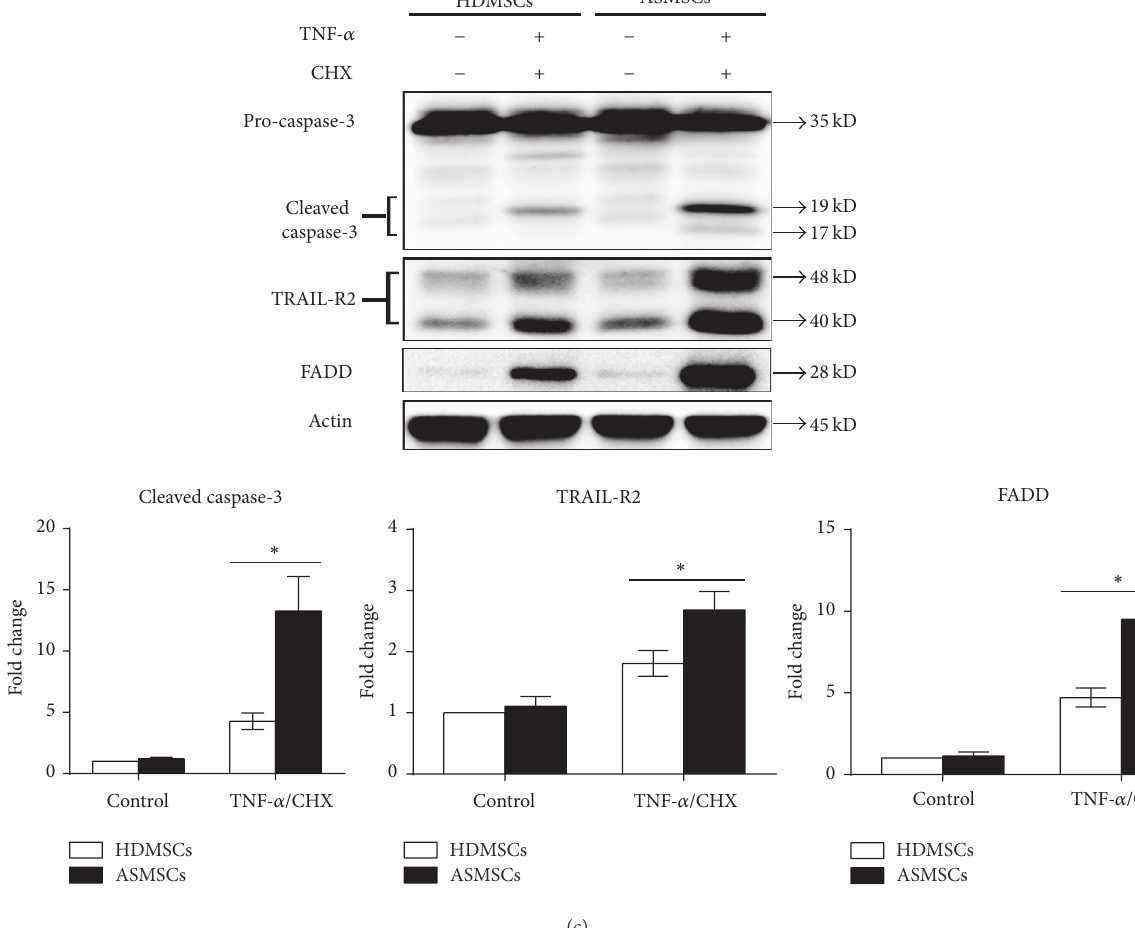
Figure 3: ASMSCs had increased protein expression of cleaved caspase-3, TRAIL-R2, and FADD and increased gene expression of TRAIL- R2 and FADD during apoptosis. (a) The Proteome Profiler (cid:2) Human Apoptosis Array Kit was used to determine the expression levels of 35 apoptosis-related proteins in HDMSCs ( 𝑛 = 6 ) and ASMSCs ( 𝑛 = 6 ) after treatment with TNF- 𝛼 /CHX. The intensity of each pair of spots represents repeated measures of one protein. ASMSCs had lower pro-caspase-3 (a.1) expression but higher cleaved caspase-3 (a.2), TRAIL-R2 (a.3), and FADD (a.4) expression levels than HDMSCs. No significant differences in the expression of the remaining 31 proteins were found between HDMSCs and ASMSCs (b) qRT-PCR was performed to confirm the results of the Proteome Profiler (cid:2) Human Apoptosis Array. The results of TRAIL-R2 and FADD in HDMSCs ( 𝑛 = 28 ) and ASMSCs ( 𝑛 = 22 ) were consistent with those of the Proteome Profiler (cid:2) Human Apoptosis Array. However, total caspase-3 mRNA expression was not different between HDMSCs and ASMSCs. (c) Western blot analysis was performed on proteins isolated from HDMSCs ( 𝑛 = 28 ) and ASMSCs ( 𝑛 = 22 ) to further confirm the results of the Proteome Profiler (cid:2) Human Apoptosis Array, and the results of both methods were in agreement. Values are presented as the mean ± SD. ∗ indicates 𝑃 < 0.05 between HDMSCs and